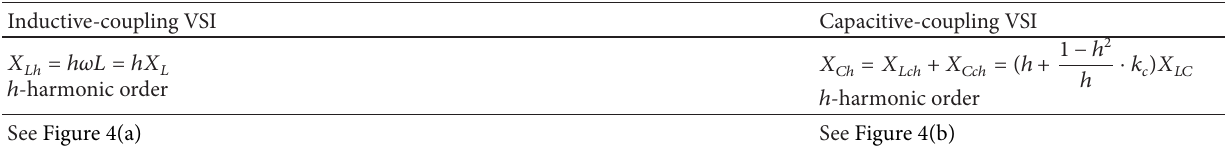
Table 2: Comparisons with harmonic suppression capability.